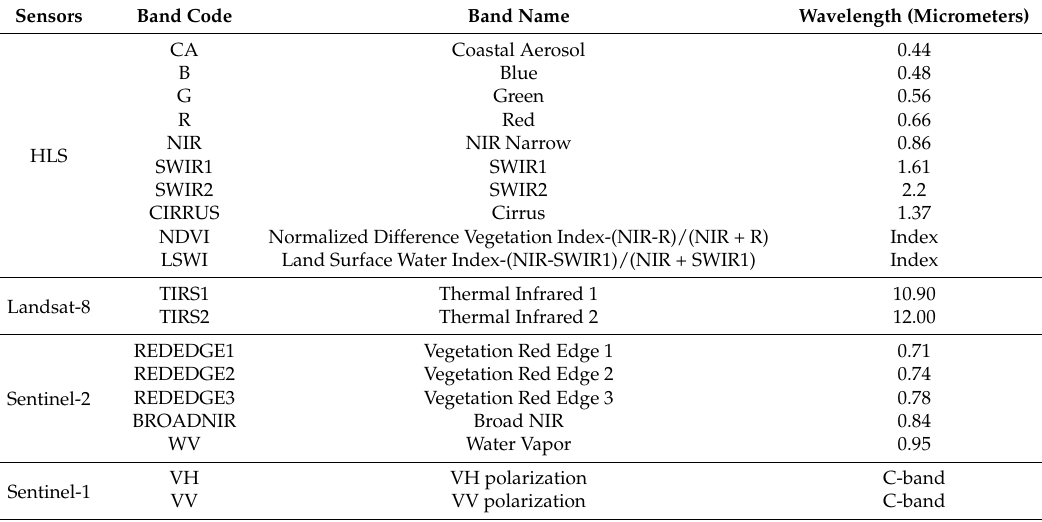
Table 1. The moderate resolution Earth observation inputs for crop